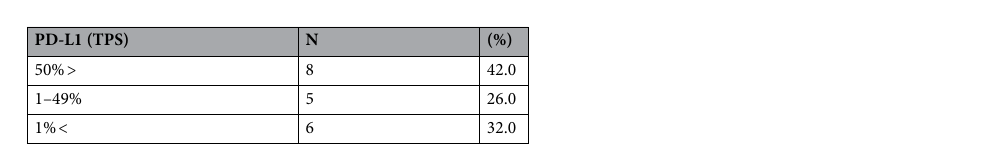
Table 3. PD-L1 status of NSCLC. PD-L1 status non-small cell lung cancer was examined through IHC using the PD-L1 IHC 22C3 PharmDx assay. TPS tumor proportion